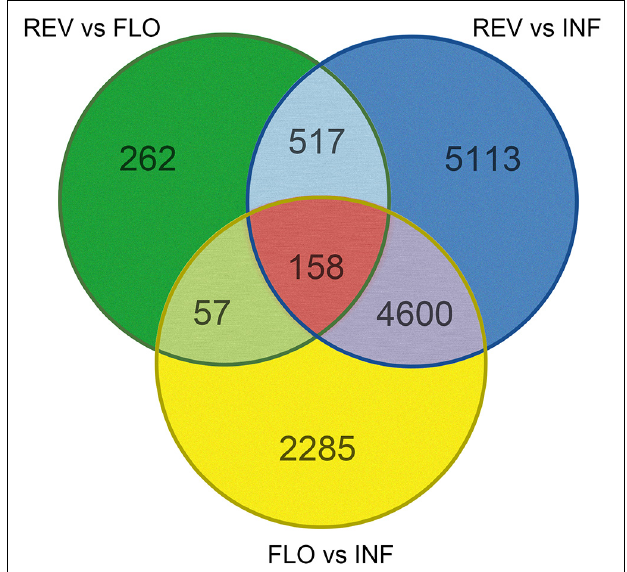
FIGURE 3 | Distribution of differentially expressed genes (DEGs) in pairwise